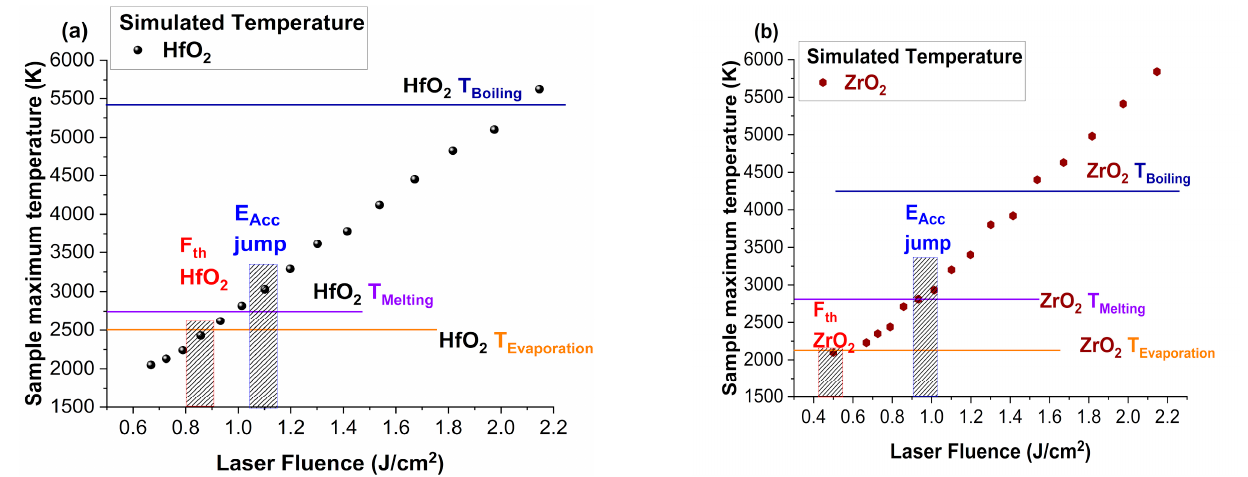
Figure 9. Peak temperature derived from heat diffusion equation for various irradiation conditions of HfO 2 ( a ) and ZrO 2 ( b ).